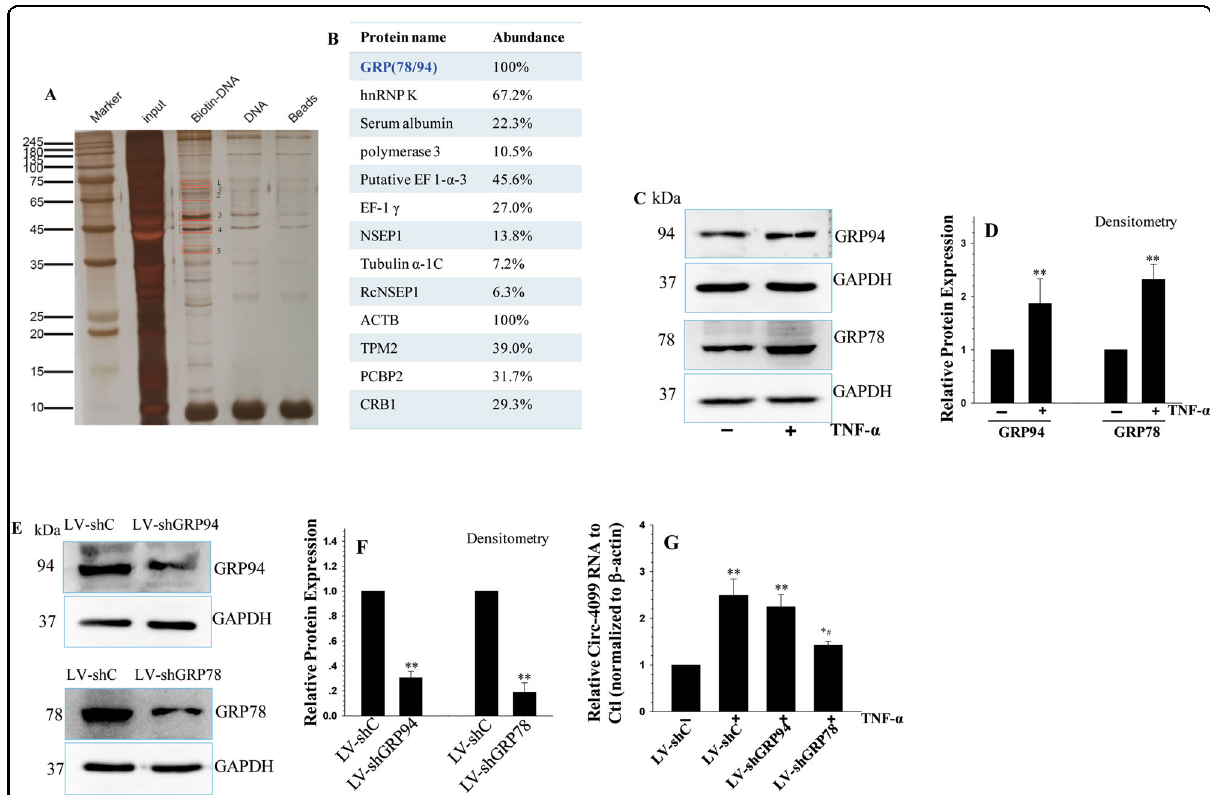
Fig. 5 Transcription factors responsible for circ-4099 expression. a Biotin-labeled circ-4099 promoter was mixed with nuclear extracts from hNP cells. b The eluted proteins in the red box were analyzed using mass spectrometry methods. c , d The GRP78/94 protein levels in the nuclei of hNP cells treated with TNF- α for 24 h were analyzed by WB. e , f The GRP78/94 protein levels in hNP cells transfected with shRNA vectors for 48 h were analyzed by WB. g circ-4099 expression was analyzed by qRT-PCR in hNP cells transfected with the sh-GRP78 RNA vector for 48 h and then treated with TNF- α for 24